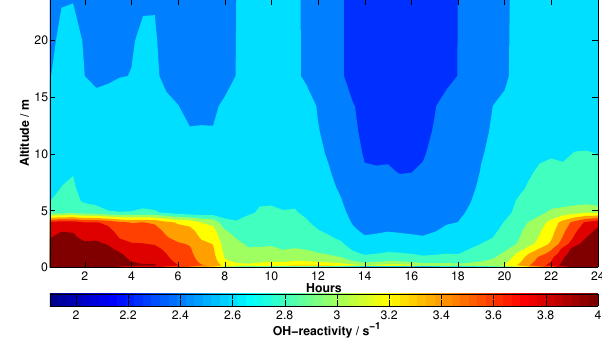
Fig. 6. Daily averaged modelled OH-reactivity from 13 to 27 Au- gust as a function of altitude.